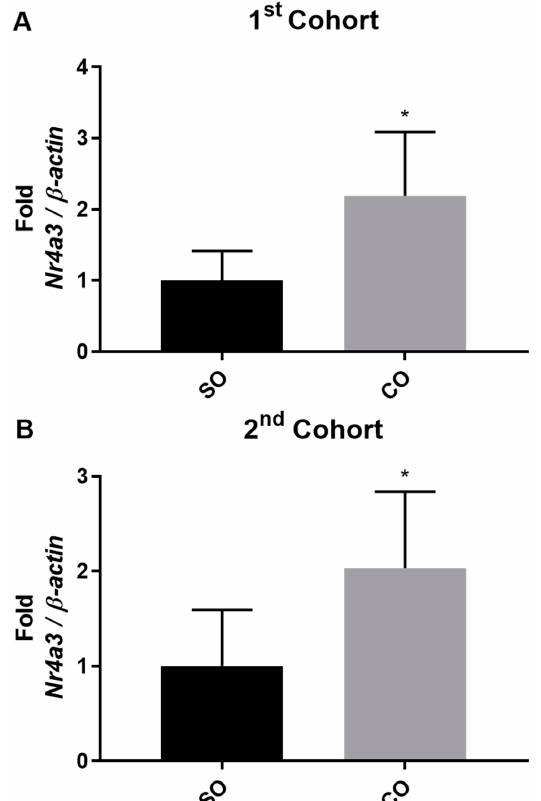
Figure 4. Cerebellar qPCR measurement of Nr4a3 . Data are reported as mean ± SD, n = 10. * Statistical significance was assessed using Student’s t -test performed on the initial Δ Ct values for the gene with p ≤ 0.05. CO: Corn oil; SO: Soybean oil; Δ Ct: Change in cycle threshold normalized to β